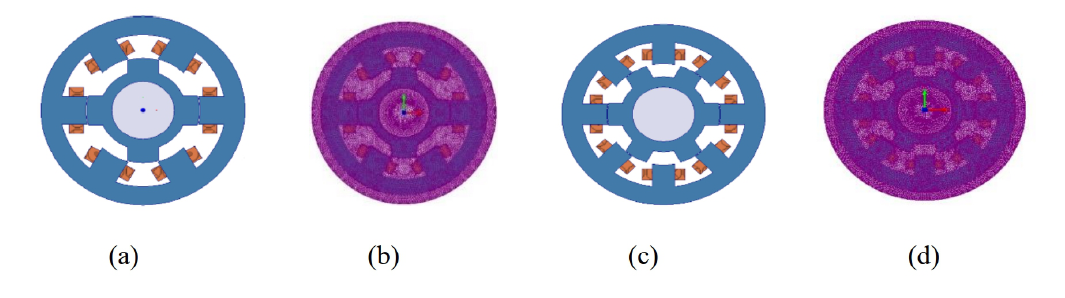
Fig. 11. Schematic diagram (a) 6/4, (c) 8/6 and Mesh node (b) 6/4, (d) 8/6.